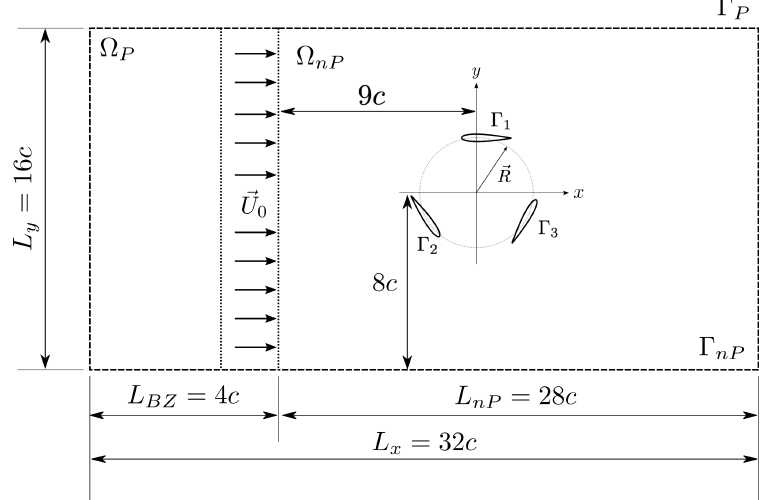
Figure 16. Calculation domain for the solution of flows over the vertical axis